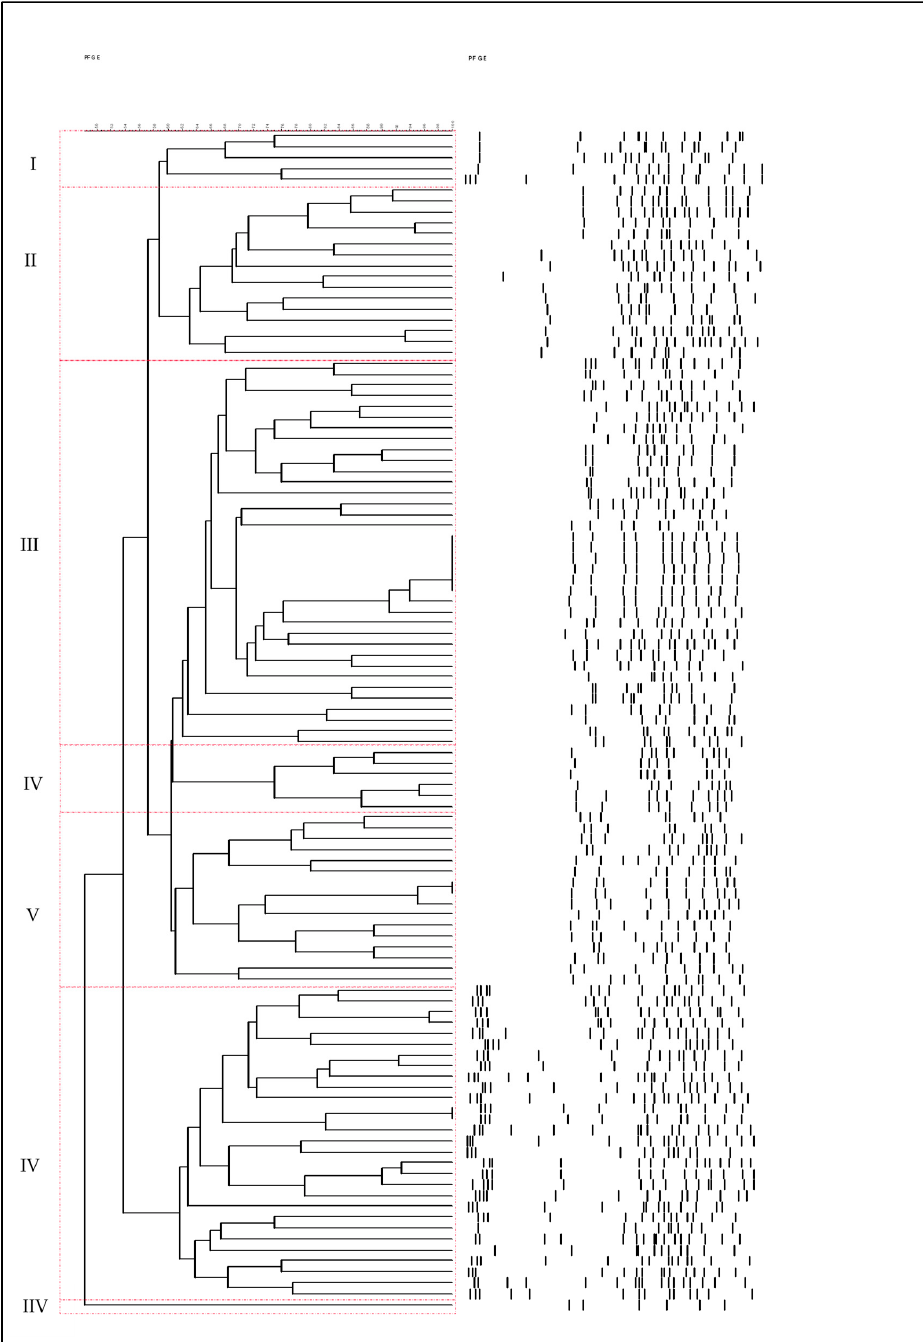
Figure 3. Cluster analysis of pulsed-field gel electrophoresis (PFGE) Apa I digestion fragments of the Brochothrix thermosphacta isolates calculated by the unweighted pair group method. 3.4. Effect of HPP on the Different Listeria Strains According to PFGE Analysis A total of 294 isolates were recovered from Palcam agar plates and the isolates were screened with PFGE to monitor the survival and the distribution of the L. monocytogenes strains on chicken